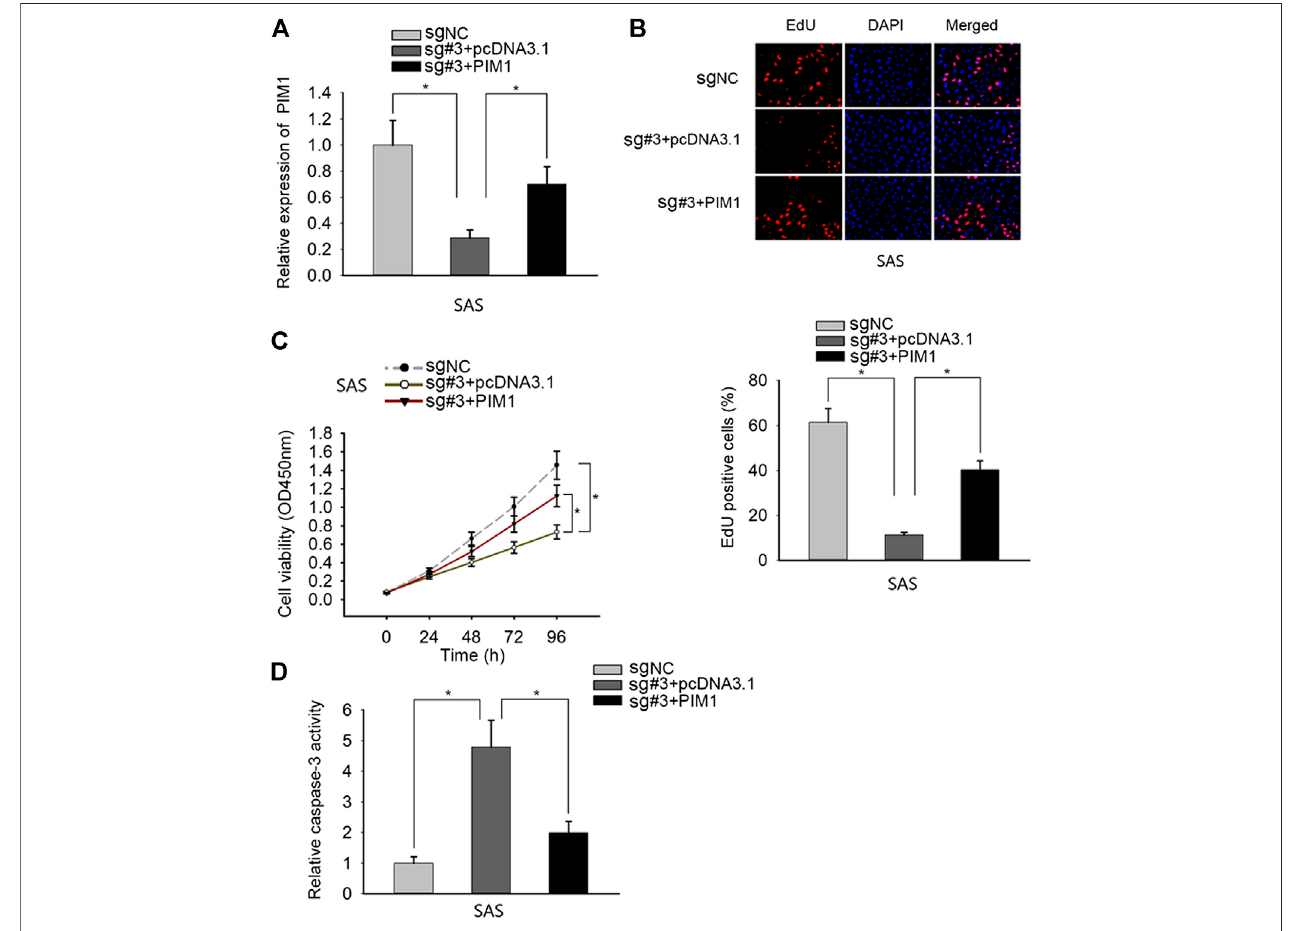
FIGURE4| PANDARmodulatedOSCCcellproliferationandapoptosisviaSRSF7/PIM1axis.( A) ThepcDNA3.1/PIM1reversedtheinhibitoryeffectonPIM1mediated byknockdownofPANDAR.( B – D)